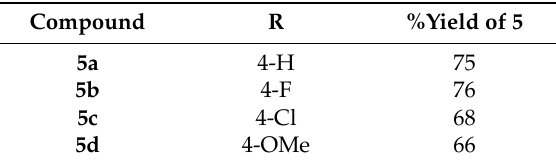
Table 4. percentage yield of compounds 5a–d .